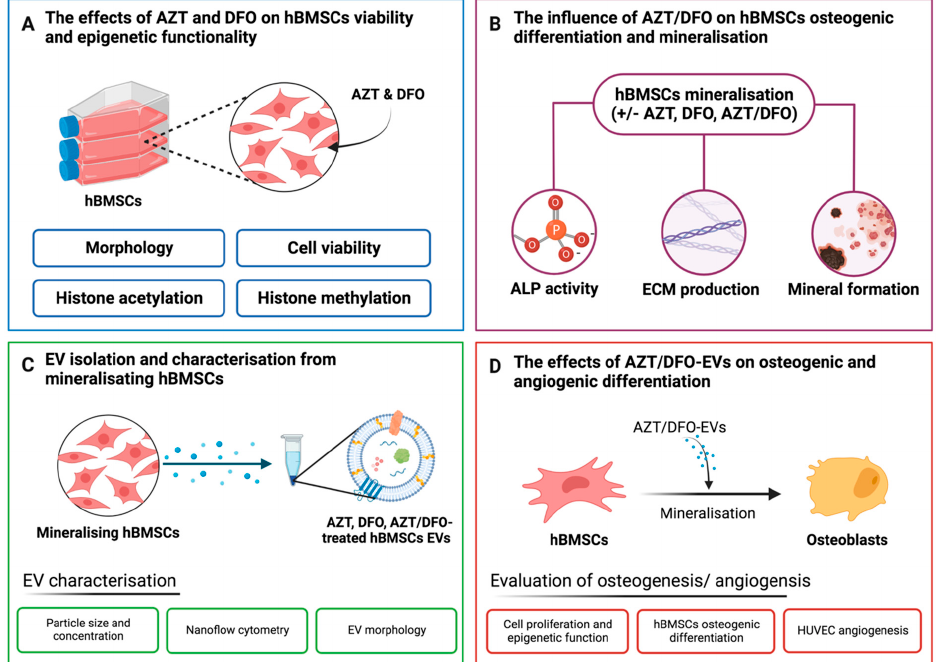
Figure 1. Schematic representation of the investigation of the effects of hypomethylation and hypoxia on the therapeutic potency of hBMSC-derived EVs for bone repair. ( A ) The influence of AZT and DFO on cell viability and epigenetic function was assessed. ( B ) The influence of AZT, DFO or AZT/DFO treatment on hBMSCs osteogenic di ff erentiation evaluated by quantifying ALP activity, collagen production and calcium deposition. ( C ) EVs were isolated from untreated, AZT-treated, DFO-treated and AZT/DFO-treated hBMSCs and characterised in terms of their size, morphology and tetraspanin markers. ( D ) The e ff ects of AZT/DFO-EVs on hBMSCs osteogenesis and HUVEC angiogenesis. Figure created with BioRender.com. (last assessed on 1 March 2023).